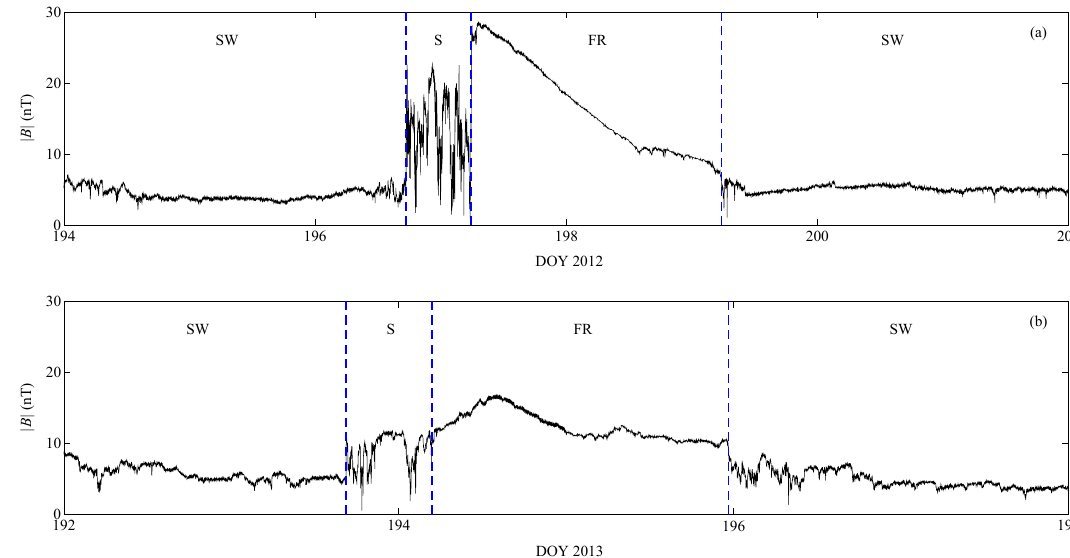
Figure 9. Time series for the magnetic field for the two magnetic cloud events analyzed. The different stages in the data are identified: solar wind (SW), sheath (S), and flux rope (FR). (a) MC1 event: 12 July 2012; (b) MC2 event: 11 July 2013.